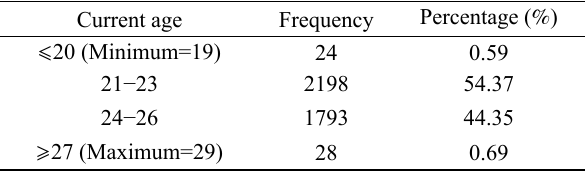
Table 6 Descriptive analysis of age factor.